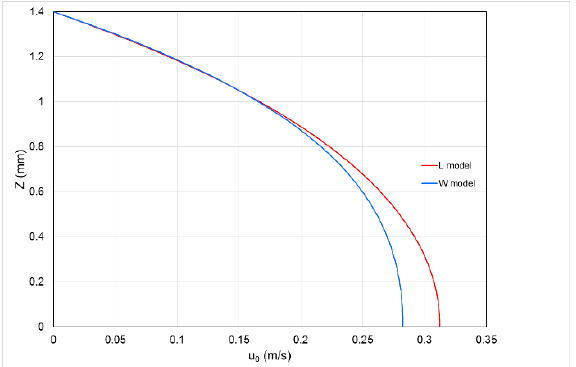
Figure 2. Microgel-free xanthan polysaccharide dissolved in a saltwater (salinity = 5 gl −1 NaCl, temperature = 30 °C); experimental data [11] fitted by W and L models.